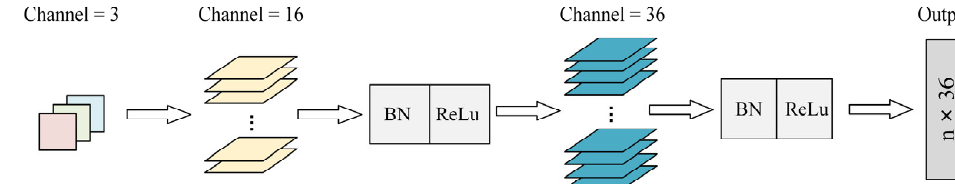
Figure 2. Architecture of